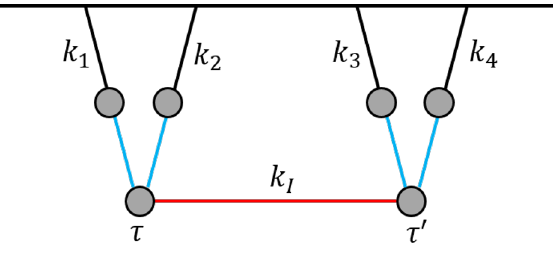
Figure 8 . Example 2: massive scalar exchange with two-point